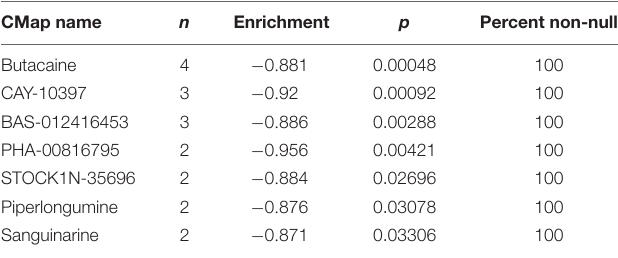
TABLE 2 | Drugs selected by